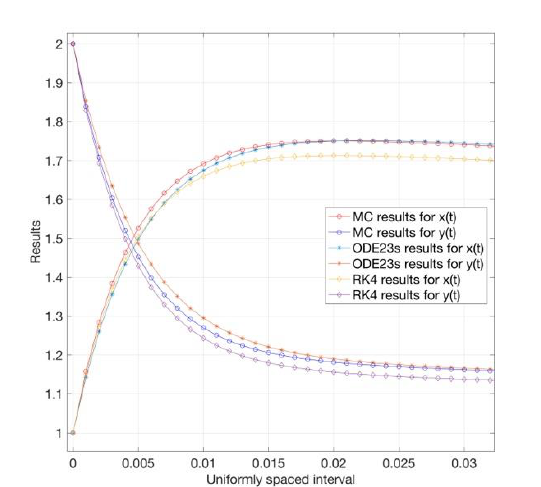
Figure 8. Comparison of the MC results with the ode23s and RK4 results for the system of differential equations (7)